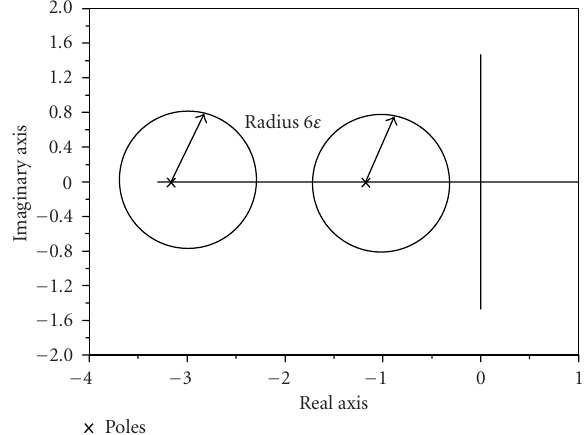
Figure 5.2. Possible situation of the first-order approximation unstable poles around the eigenvalues of A for ε = 0 .